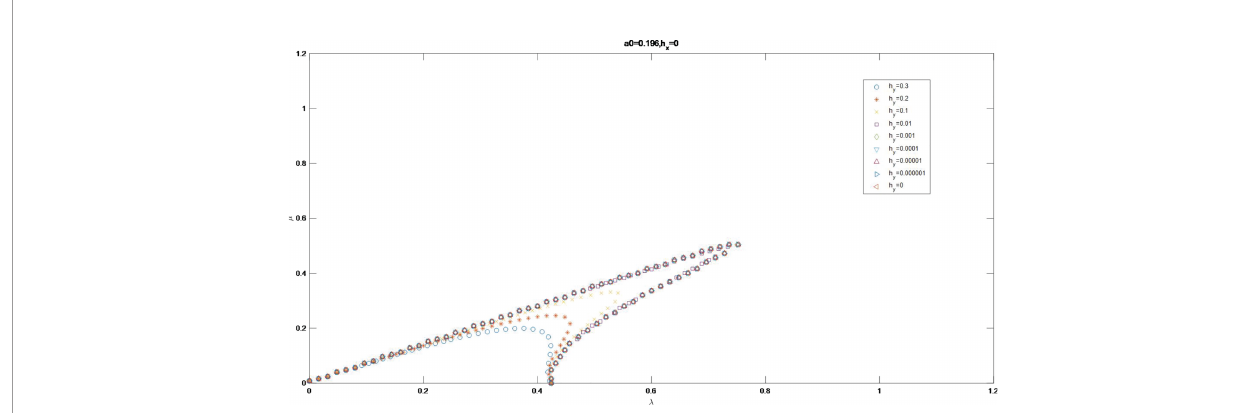
FIGURE 2 | The magni fi ed curves of Im W = 0 for a 0 = 0.196 and ∂ h ∂ x = 0.